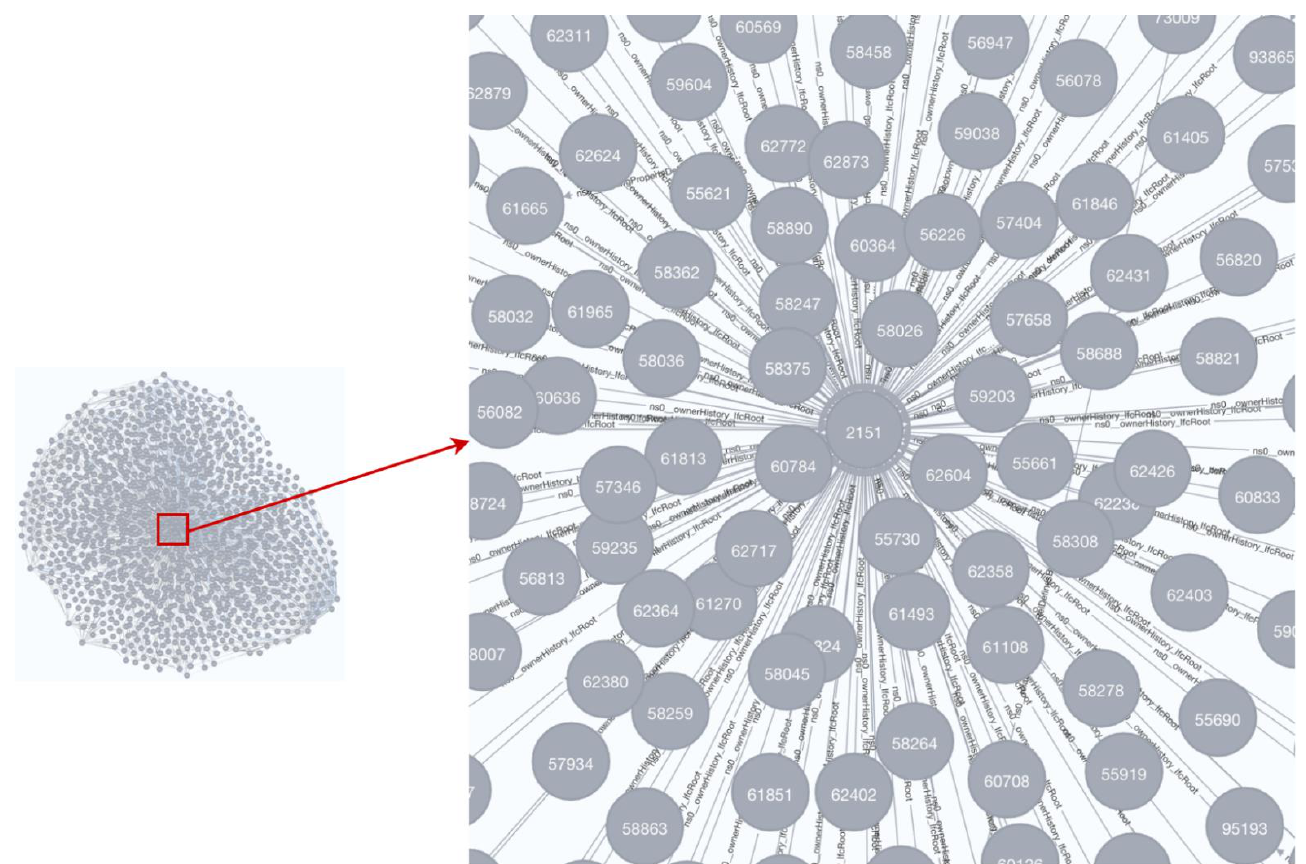
Figure 17. The shortest path problem in representing IFC data using graph.